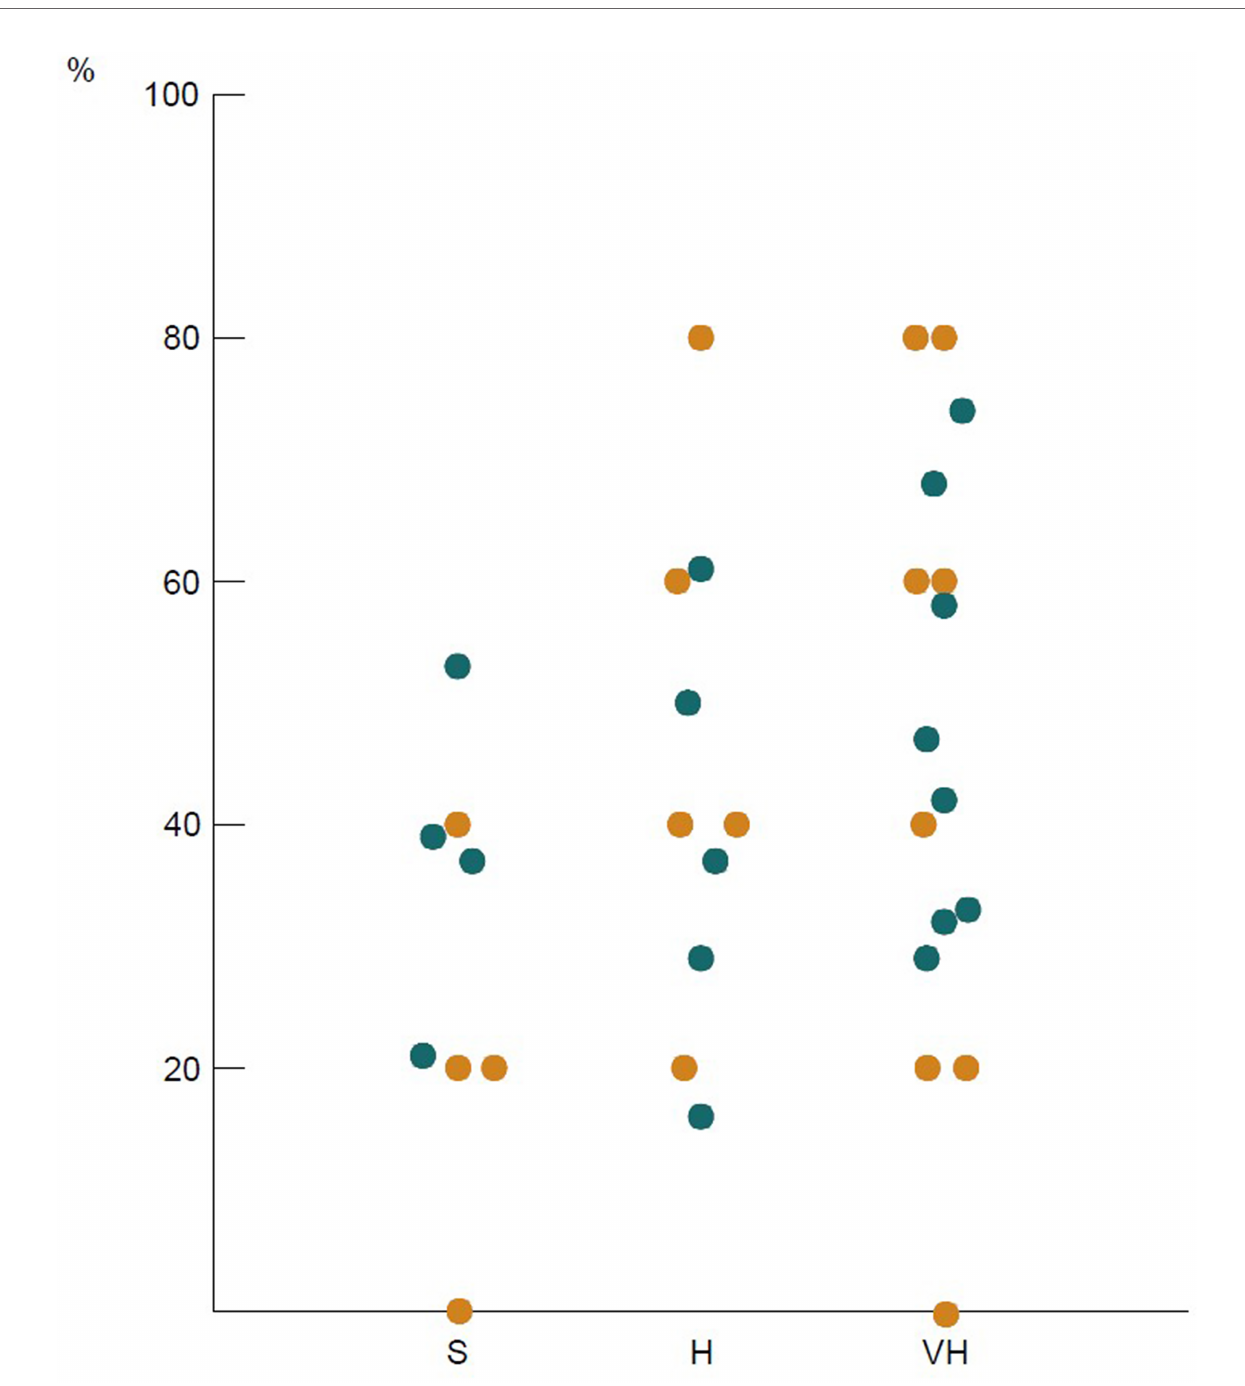
FIGURE 3 | Intra-institutional variation in responses: each dot represents the percentage of questions across the survey with different answers from surgeons in the same institution. Columns refer to standard (S), high (H), and very high (VH) volume hospitals; orange dots: clinical vignettes, blue dots: other